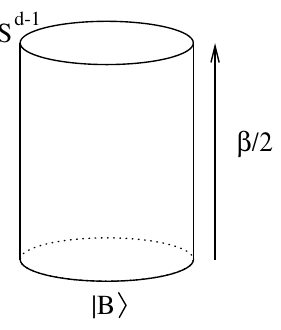
Figure 4 . Path integral description of black hole microstates j (cid:9) (cid:12)